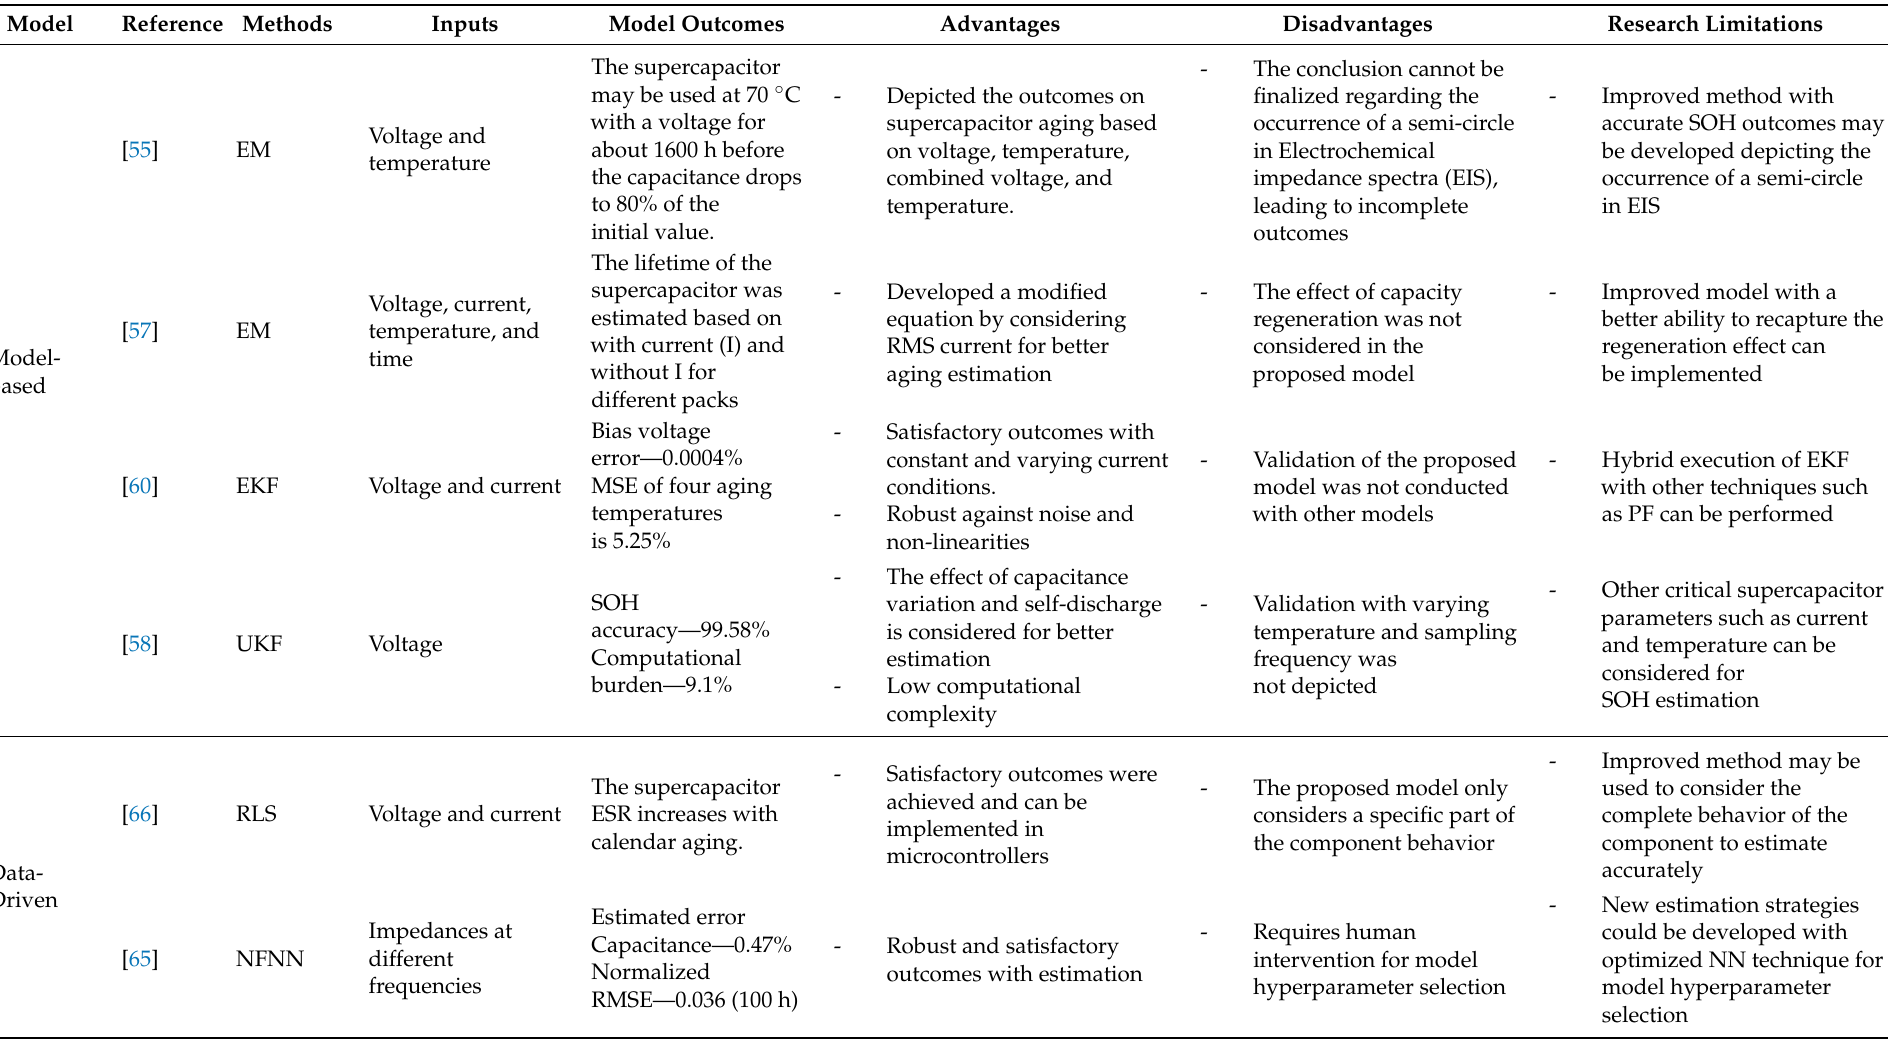
Table 2. Comparative analysis of model-based and data-driven methods for SOH estimation of